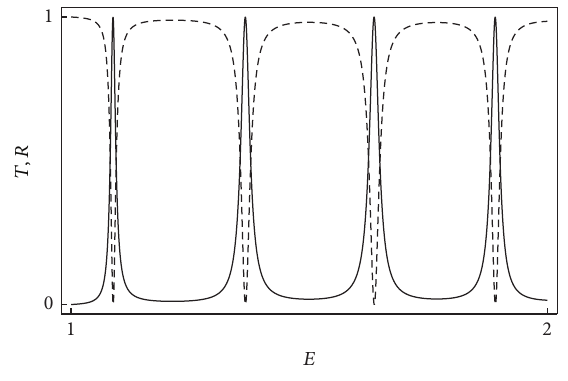
Figure2:Theplotofunitaritycondition, 𝑅+𝑇 = 1 ,withtheposition dependent mass for 𝑞 = 1.5 , ̃𝑞 = 1.5 , 𝑝 = 2 , ̃𝑝 = 2 , 𝐿 = 5 , = 5 , 𝑚 = 1 , and 𝑚 → 0 𝑎 = 3 , 𝑏 = 3 , 𝑉 0 0 1